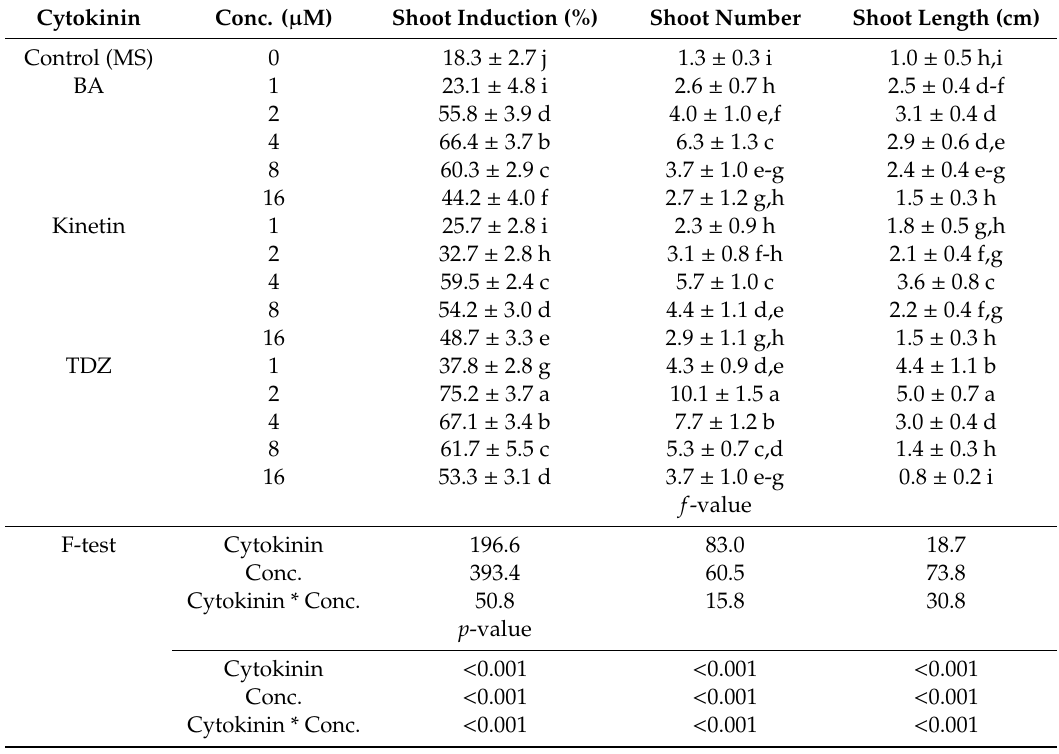
Table 1. E ff ect of cytokinins on multiple shoot regeneration from nodal explants of Catharanthus roseus. Cytokinin Conc. ( µ M) Shoot Induction (%) Shoot Number Shoot Length (cm) Control